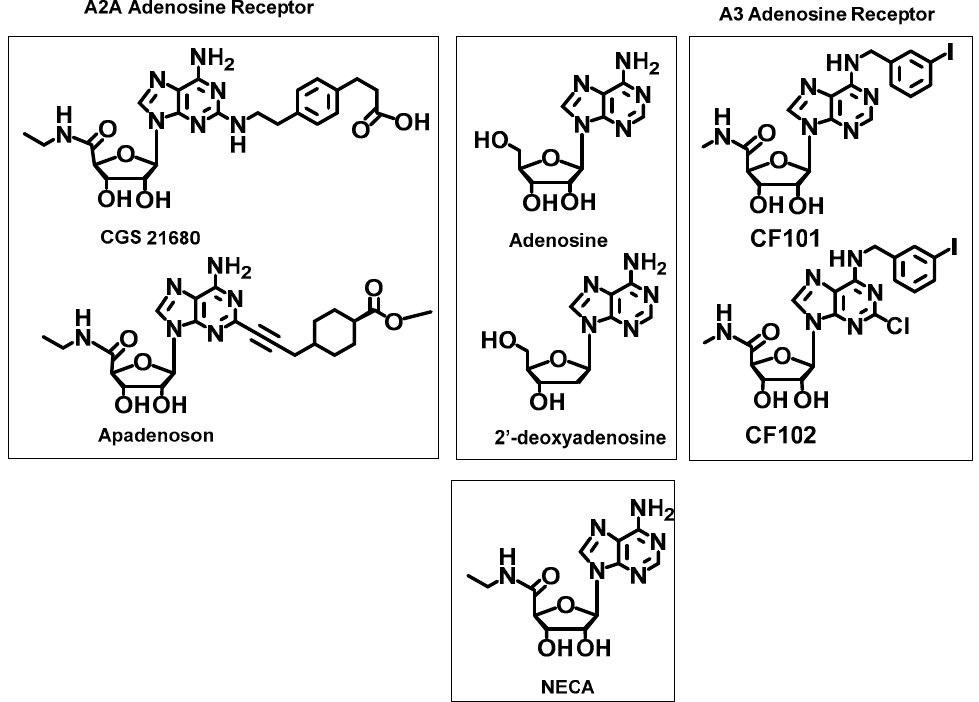
Figure 4. Reference ligands used to validate the PatchDock docking methods.